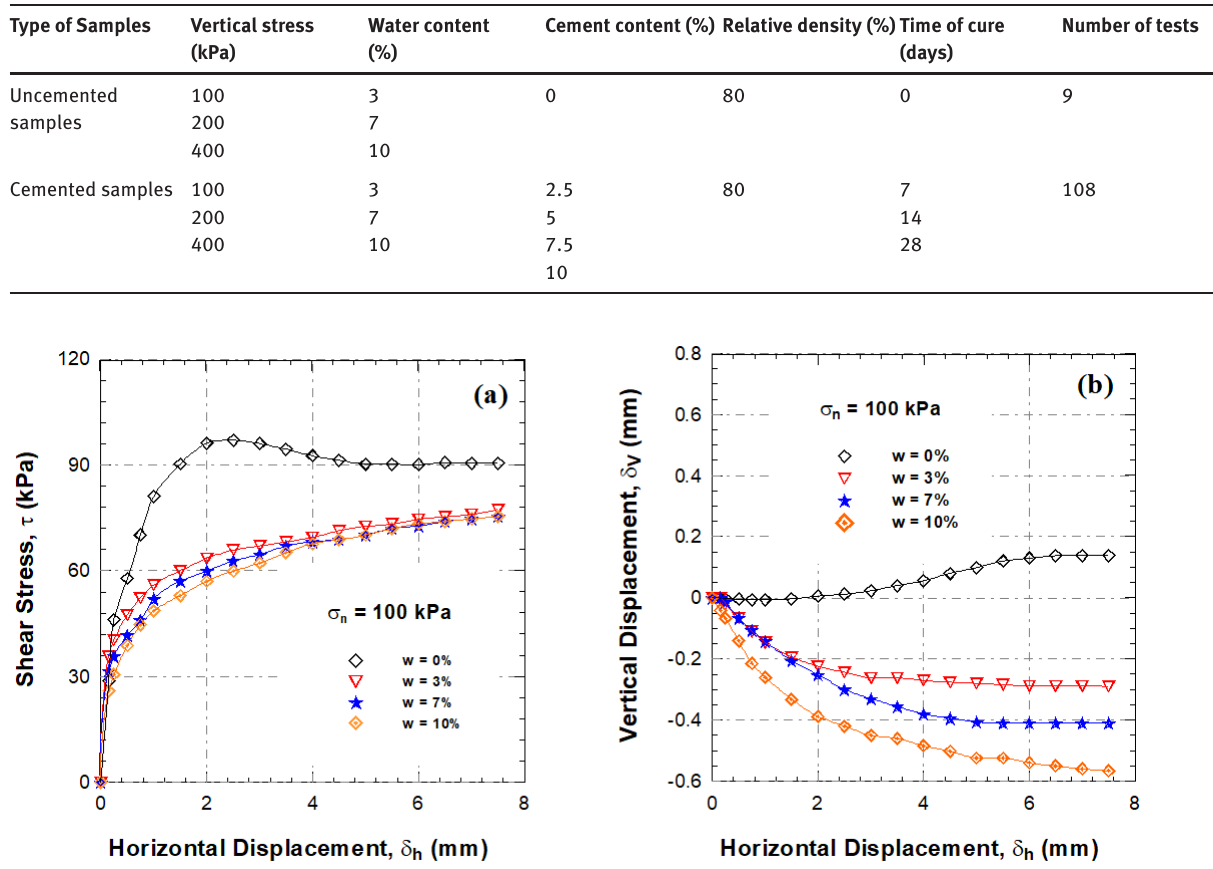
Figure 4: Influence of water content on the behavior of Chlef sand ( σn = 100 kPa, Dr = 80%), (a): Shear stress as a function of horizontal displacement, (b): Vertical displacement as a function of horizontal